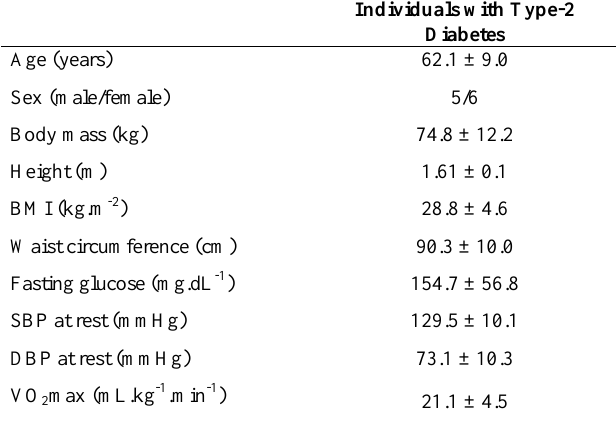
Table 1. Main characteristics of the participants (n=11). Data is presented in mean ± standard deviation.